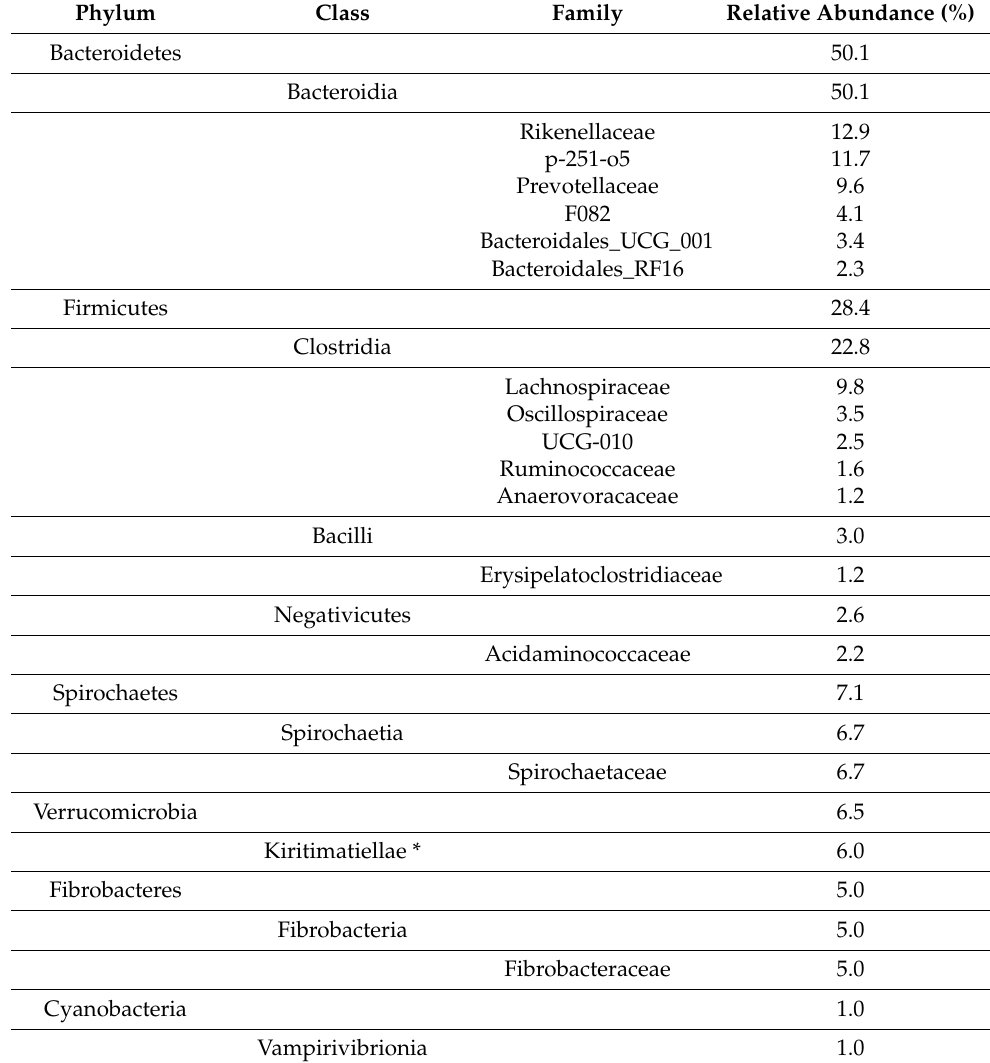
Table 2. Phyla, classes and families with a relative abundance of >1% in the faecal